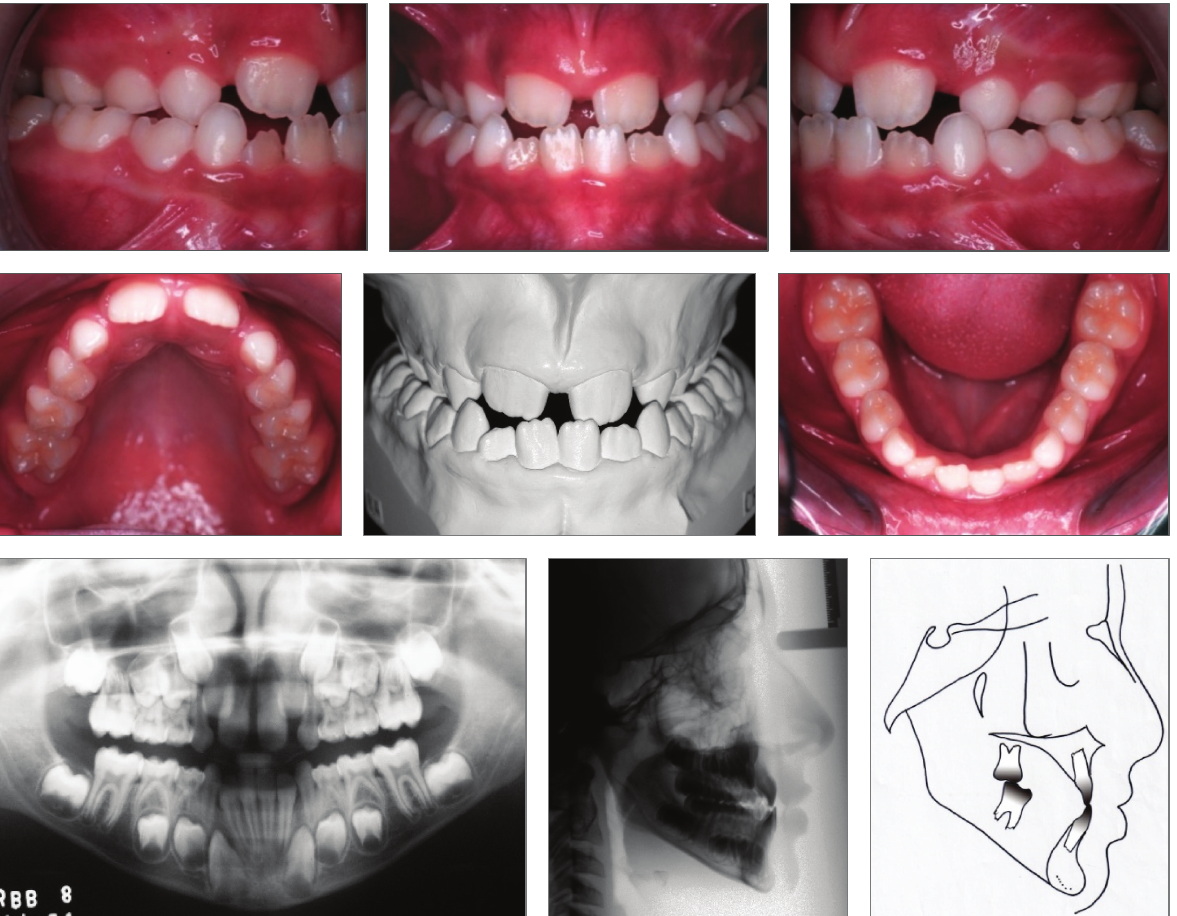
Figure 1: Pretreatment intraoral photographs, panoramic and cephalometric radiographs, and cephalometric tracing. Angle Class III malocclusion. Complete maxillary